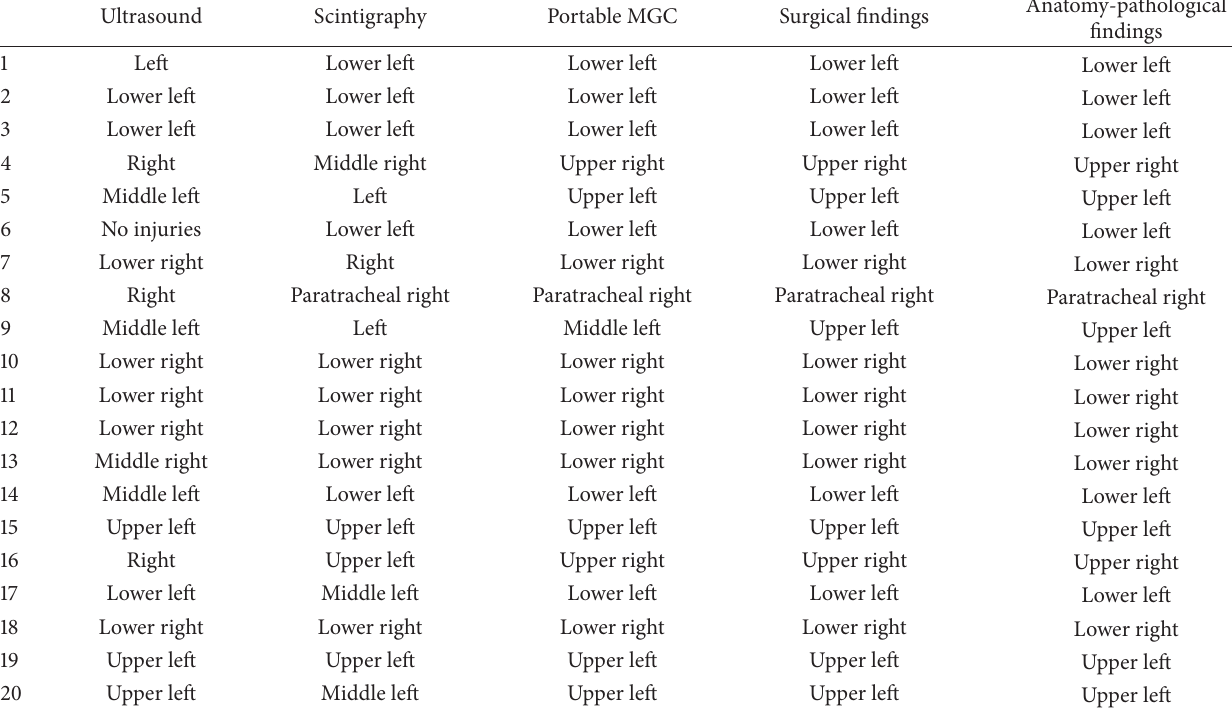
Table 2: Results of preoperative and intraoperative surgical findings and pathological anatomical study locators.